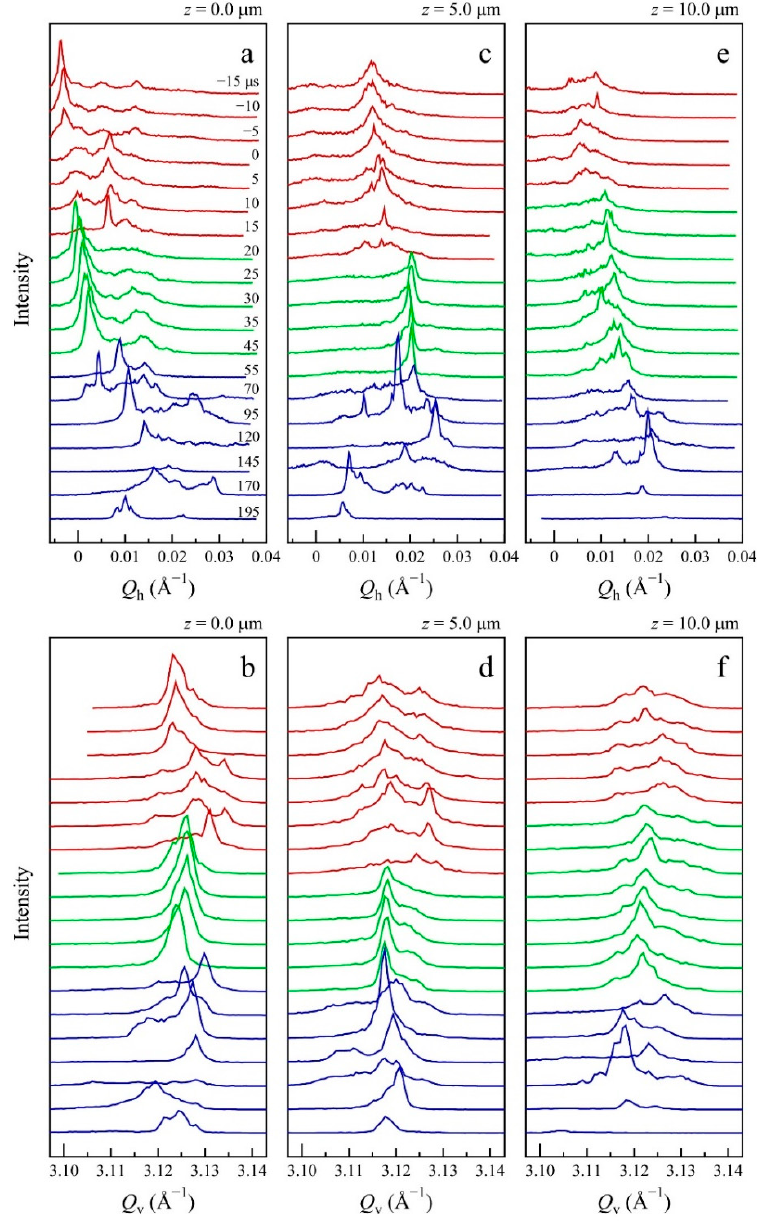
Figure 4. Time ( ∆ t ) dependences of Q h and Q v one-dimensional profiles of the 002 Bragg peak through the intensity maxima at z = ( a , b ) 0.0, ( c , d ) 5.0, and ( e , f ) 10.0 µ m in the time-resolved nanobeam XRD for local structure under AC field. Profiles before, during, and after polarization switching are colored in red, green, and blue,